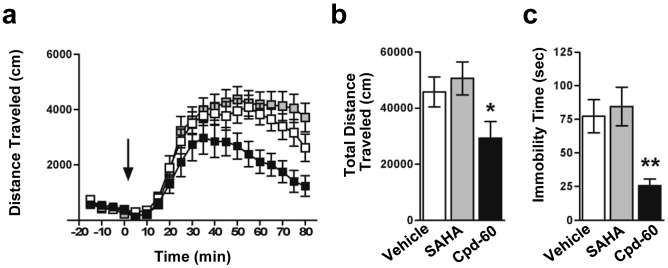
Effect of Cpd-60 treatment on mood-related behaviors in mice.(a) Timecourse of locomotor activity in response to and (b) total locomotor activity summed over 80 min following acute amphetamine challenge (3.5 mg/kg, i.p.; Time ‘0’ indicated by arrow). Hyperlocomotion in response to amphetamine was significantly reduced in mice chronically treated with Cpd-60 (45 mg/kg, i.p.) but not with SAHA (25 mg/kg, i.p.). (c) Time spent immobile in the forced swim test was significantly decreased in mice treated chronically with Cpd-60 but not SAHA compared to vehicle treated control mice. *p<0.05, **p<0.01, ANOVA with Least Significant Difference post hoc test.